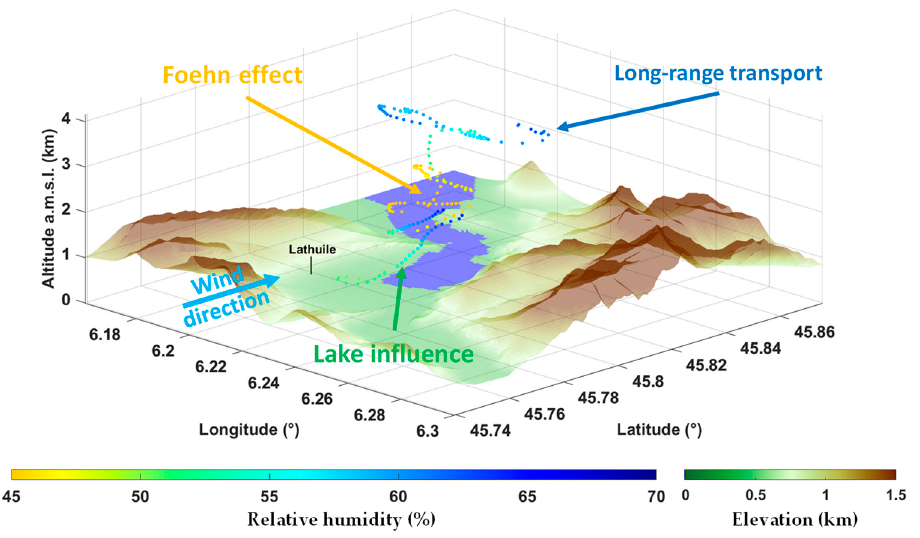
Figure 7. Relative humidity (RH) measured by the meteorological probe on the ultralight on 14 June 2019, 17:30–18:30 LT.